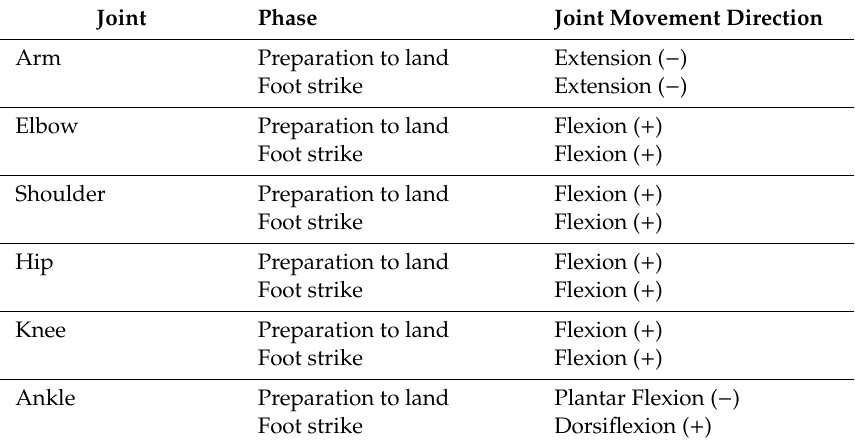
Table 1. Movement of each joint segment during a parachute